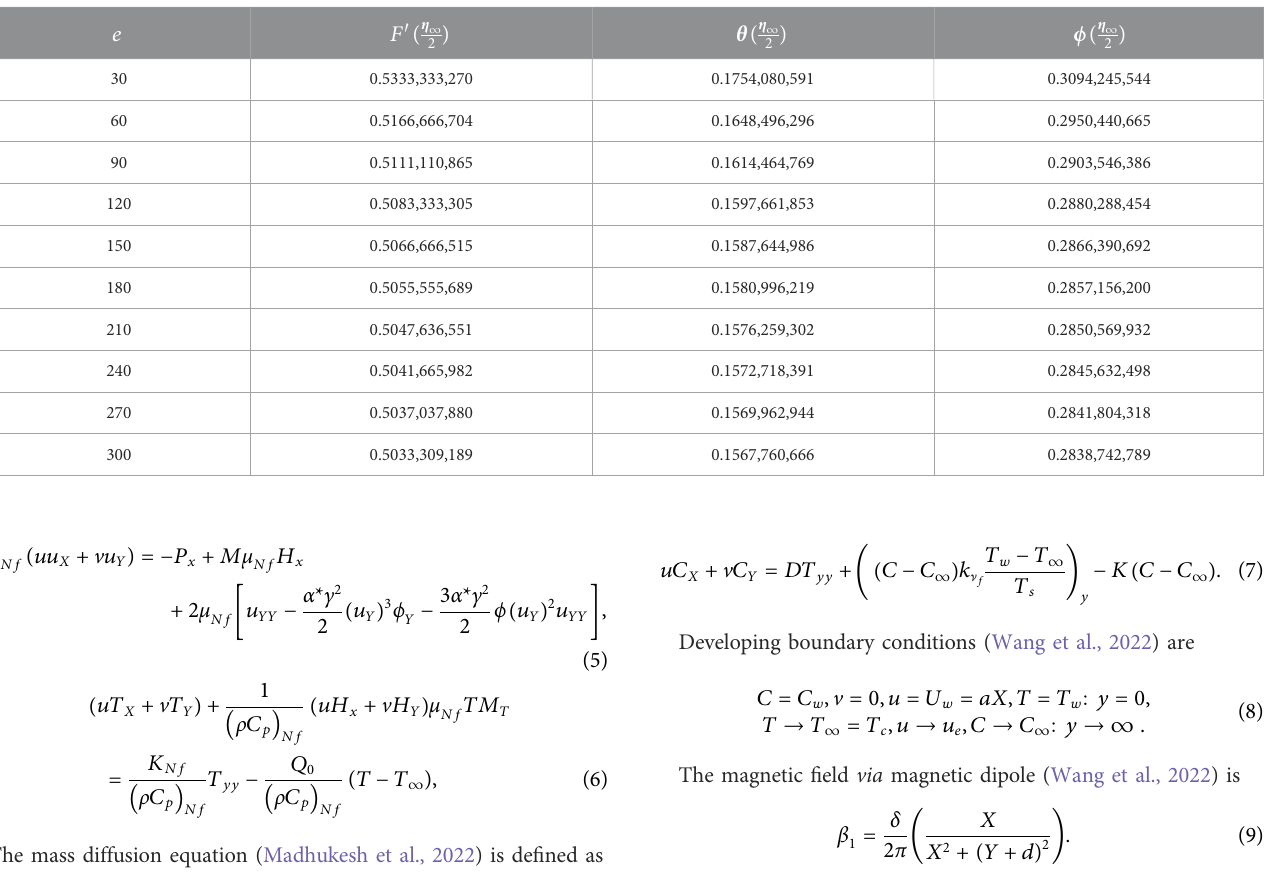
TABLE 3 Grid size analysis in terms of velocity, concentration, and temperature fi elds simulated by 300 elements when α (cid:2) 2 . 0 ,n (cid:2) 0 . 5 ,Re (cid:2) 2 . 0 , γ (cid:2) 3 . 0 , β (cid:2) 1 . 3 , (cid:2) 2 . 0 ,Sc (cid:2) 0 . 4 , λ (cid:2) 0 . 4 ,K (cid:2) − 1 . 5 , χ (cid:2) 0 . 3 , τ (cid:2) 0 . 3 , and We (cid:2) 0 . 7 Λ (cid:2) 0 . 3 ,Pr (cid:2) 5 . 0 , ϵ (cid:2) 0 . 1 ,H t c